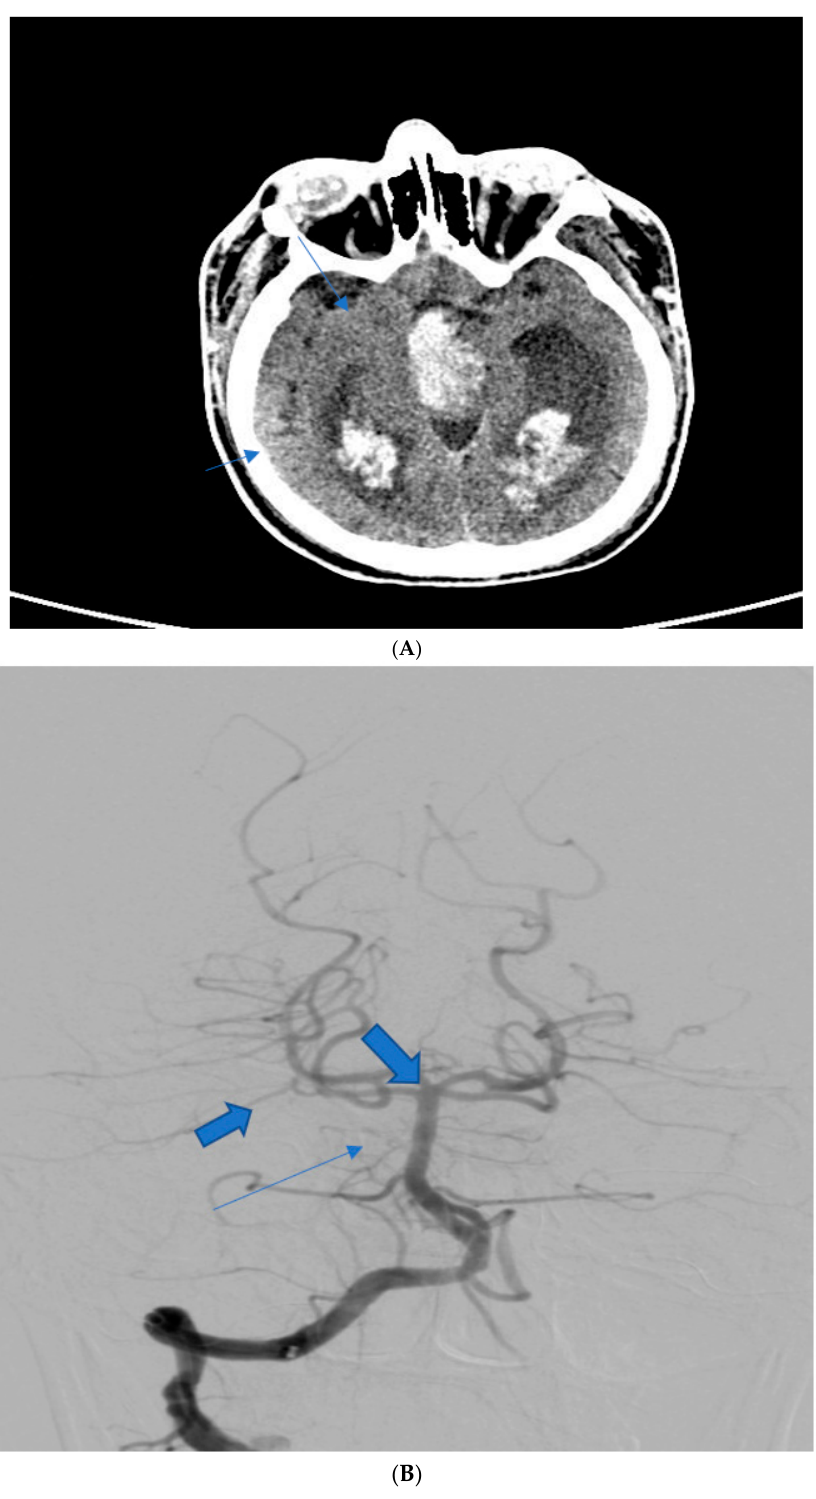
Figure 2. ( A ) The case of a 61-year-old male who was brought to the emergency department with altered mental status and tetraplegia. Native CT scan reveals a massive perimesencephalic haemor- rhage with extension to the lateral ventricles with a mFisher scale of 4 points. The patient received depletive therapy as well as nimodipine with an unfavourable outcome as he died one day following admission. ( B ) The same case of the 61-year-old male after digital subtraction angiography was performed showing no aneurysmal dilatation of the basilar (small arrow), posterior cerebral and superior cerebellar arteries (larger